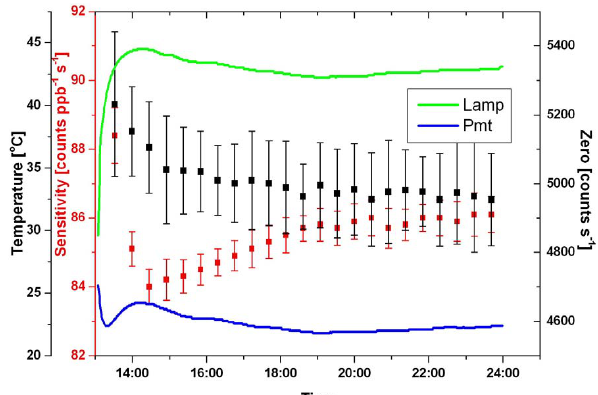
Fig. 2. Sensitivity (red), zero signal (black, right y-axis), and tem- Fig. 2: Sensitivity (red), zero signal (black, right y-axis), and temperatures of the 5 peratures of the photomultiplier (blue) and of the lamp (green) dur- photomultiplier (blue) and of the lamp (green) during flight #347 from Frankfurt to 6 Bogotá on June 16, 2011. The temperatures were recorded continuously, while the zero 7 ing flight #347 from Frankfurt to Bogot´a on 16 June 2011. The tem- signal and the sensitivity were only measured during the calibration cycles every 25 min. 8 peratures were recorded continuously, while the zero signal and the The error bars give the 1 σ variation during the last 60 s of each calibration cycle. 9 10 sensitivity were only measured during the calibration cycles every 25min. The error bars give the 1 σ variation during the last 60s of each calibration